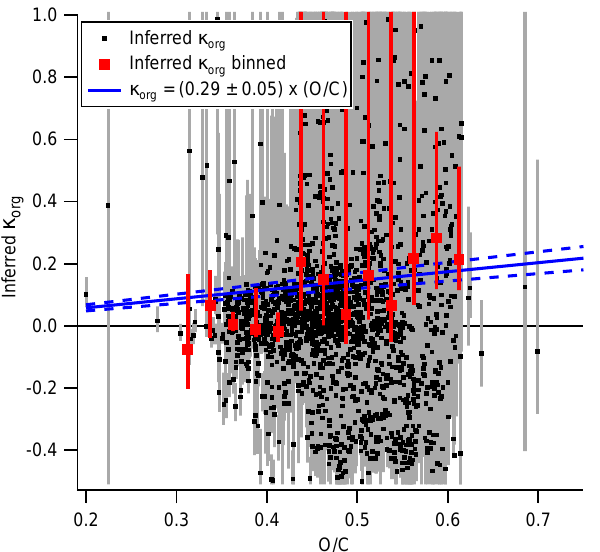
Fig. 4. κ org inferred from size distributions as a function of O/C. Grey lines are the uncertainties in the inferred κ org . Red points are data binned by 0.025. The uncertainties in the O/C for the binned data points are ± 0.1. See text for more detail.